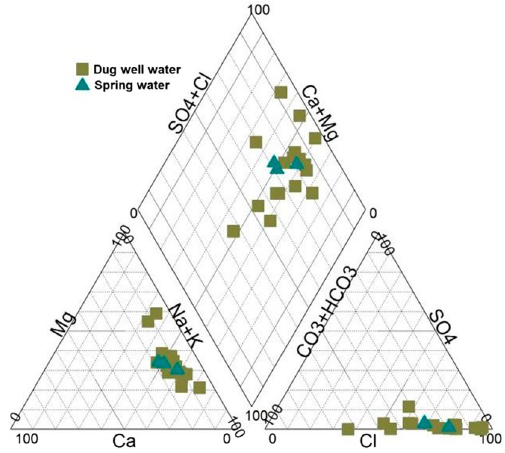
Fig. 4 Piper diagram of the water samples in the study